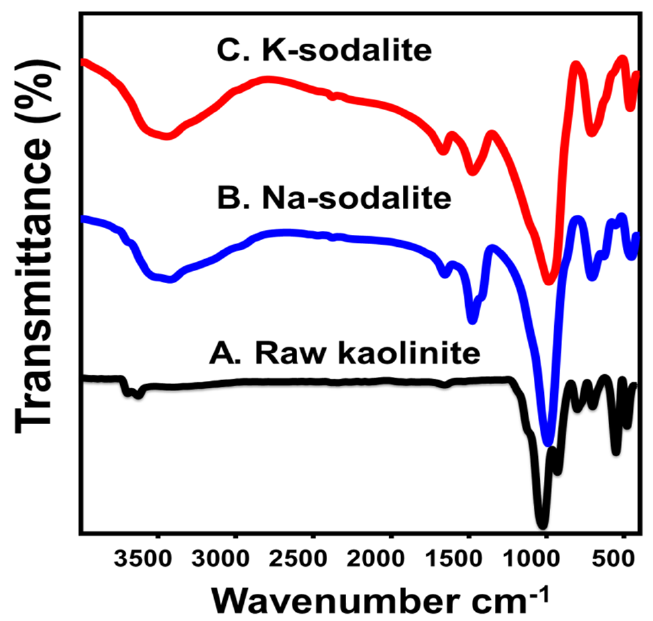
Figure 3. The FT–IR spectra of the used kaolinite ( A ), Na–sodalite (Na.SD) ( B ), and K–sodalite (K.SD) ( C ).